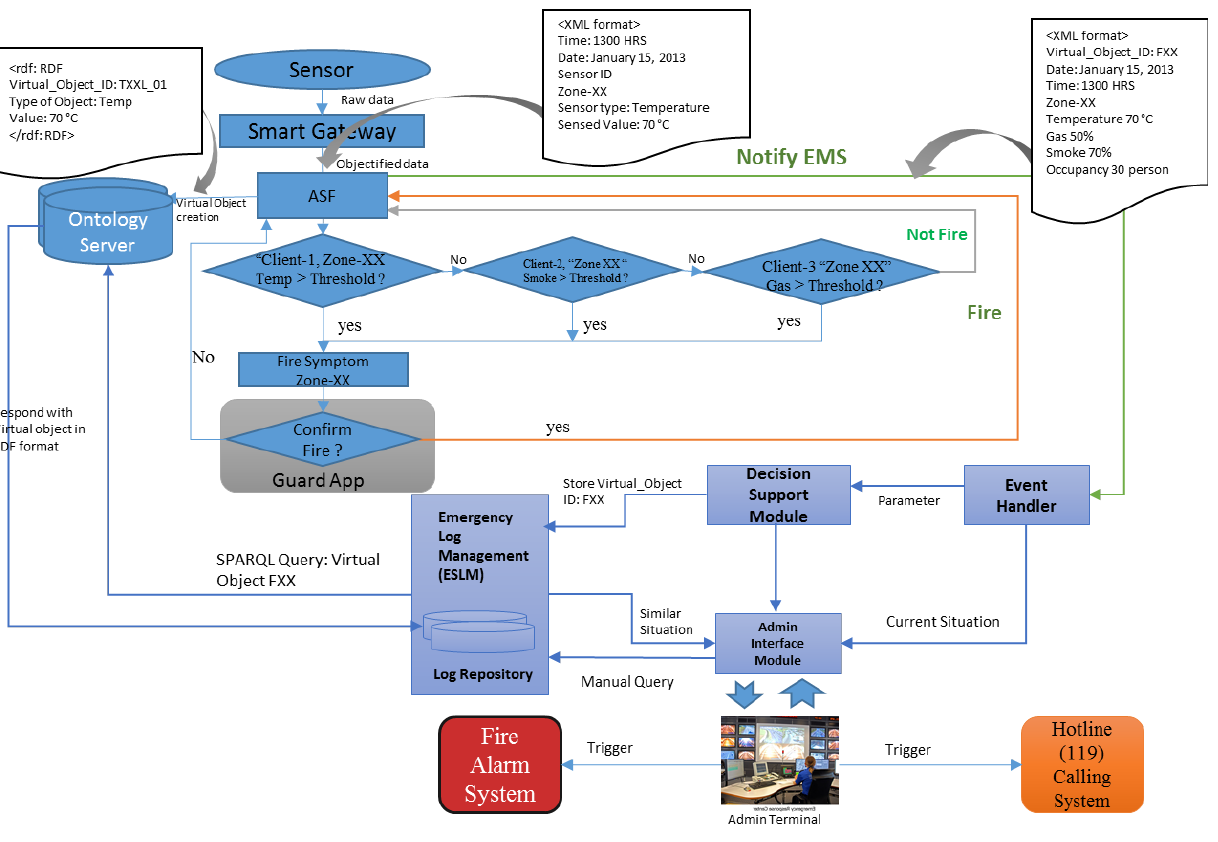
Figure 13. Implementation scenario in the form of flow diagram of emergency fire detection and management.